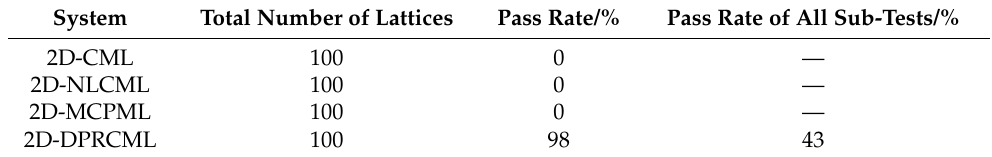
Table 4. The results of frequency